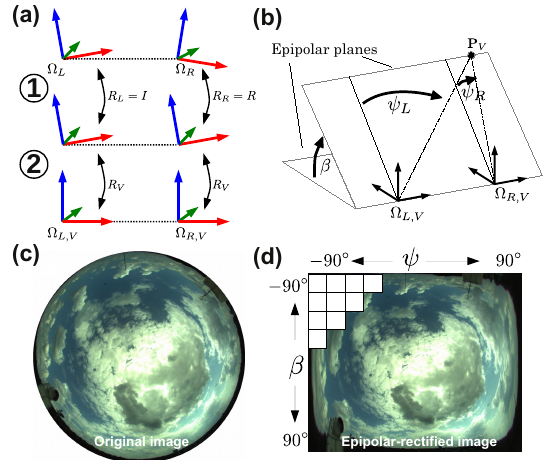
Figure 4. Epipolar rectification for omnidirectional cameras: the two-step rotational mapping between real and virtual cameras (a) results in a canonical camera setup of virtual cameras during recti- fication (b) . A fisheye image (c) is rectified such that the angles β and ψ correspond to the lines and rows of the image (d)